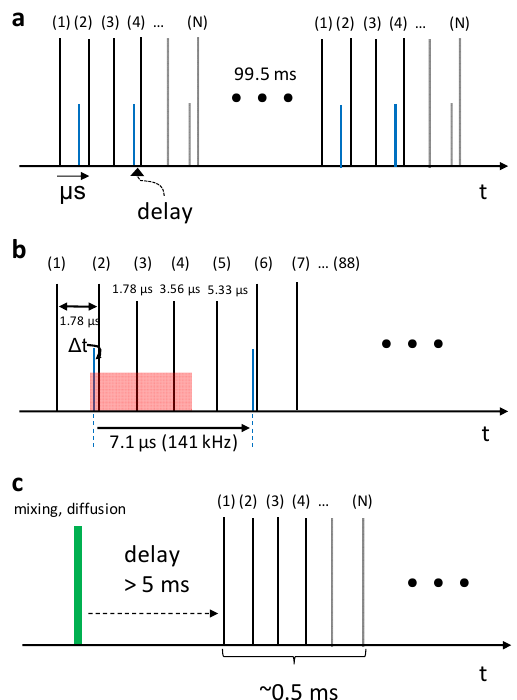
Figure 5. Timing schemes for ultrafast pump-probe strategies ( a ), ( b ), and mix-and-inject ( c ) experiments. ( a ) Intra-train reaction initiation: N X-ray pulses, each, are in a pulse train separated by up to a few μ s depending on the pulse rate of the EuXFEL (European XFEL). Before an individual X-ray pulse arrives, the reaction is initiated by an optical laser pulse (blue). Short time-delays on the femtosecond time scale can be reached. One X-ray pulse in between probes a reference in the dark. The pulse trains repeat every 99.5 ms. ( b ) A real example from the first TR-SFX experiment at the EuXFEL with 88 pulses per train, 556 kHz X-ray pulse repetition rate and 141 kHz laser excitation (blue bars). The red box denotes the time it takes for the laser excited jet volume to move out of the X-ray interaction region. ( c ) Green bar: the reaction initiation by mixing and diffusion (mix-and-inject); the millisecond time scale is probed on time scales > 5 ms by the entire pulse train. Since the time-delay is fixed by the distance between the mixing region and the X-ray interaction region, all X-ray pulse in the train (as well as in all subsequent trains) contribute to the same time-delay. This figure is a modified version of the one shown in Pandey et al. [66].